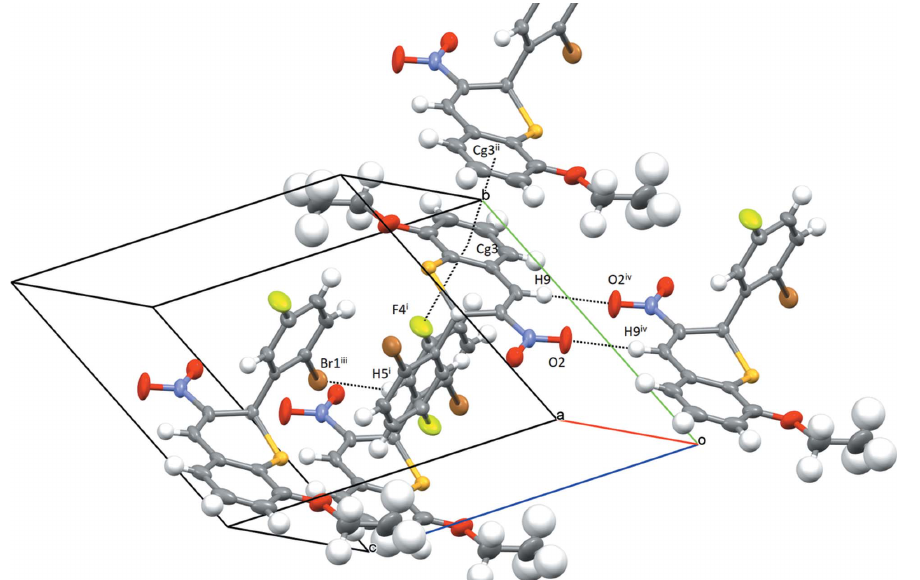
Figure 3 Packing diagram for A , showing C—H (cid:2)(cid:2)(cid:2) O, C—F (cid:2)(cid:2)(cid:2) (cid:2) , (cid:2) – (cid:2) and H (cid:2)(cid:2)(cid:2) Br interactions [symmetry codes: (i) (cid:5) x , (cid:5) y + 1, (cid:5) z + 1; (ii) (cid:5) x , (cid:5) y + 2, (cid:5) z ; (iii) (cid:5) x + 1, (cid:5) y + 1, (cid:5) z + 1; (iv) (cid:5) x , (cid:5) y + 1, (cid:5) z ]. Cg 3 is the centroid of the C10–C15